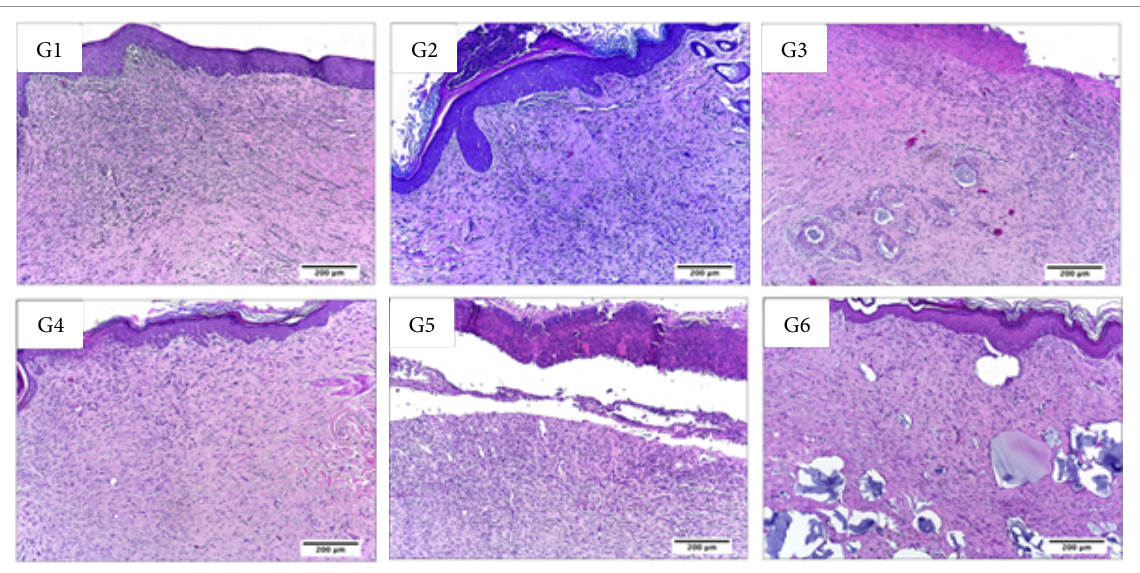
Figure 8 - Microscopic aspects of partial thickness burn wounds experimentally induced in Wistar rats 30 days after the injury induction. Stain hematoxylin and eosin. Augmentation: 10x scale in μ m.